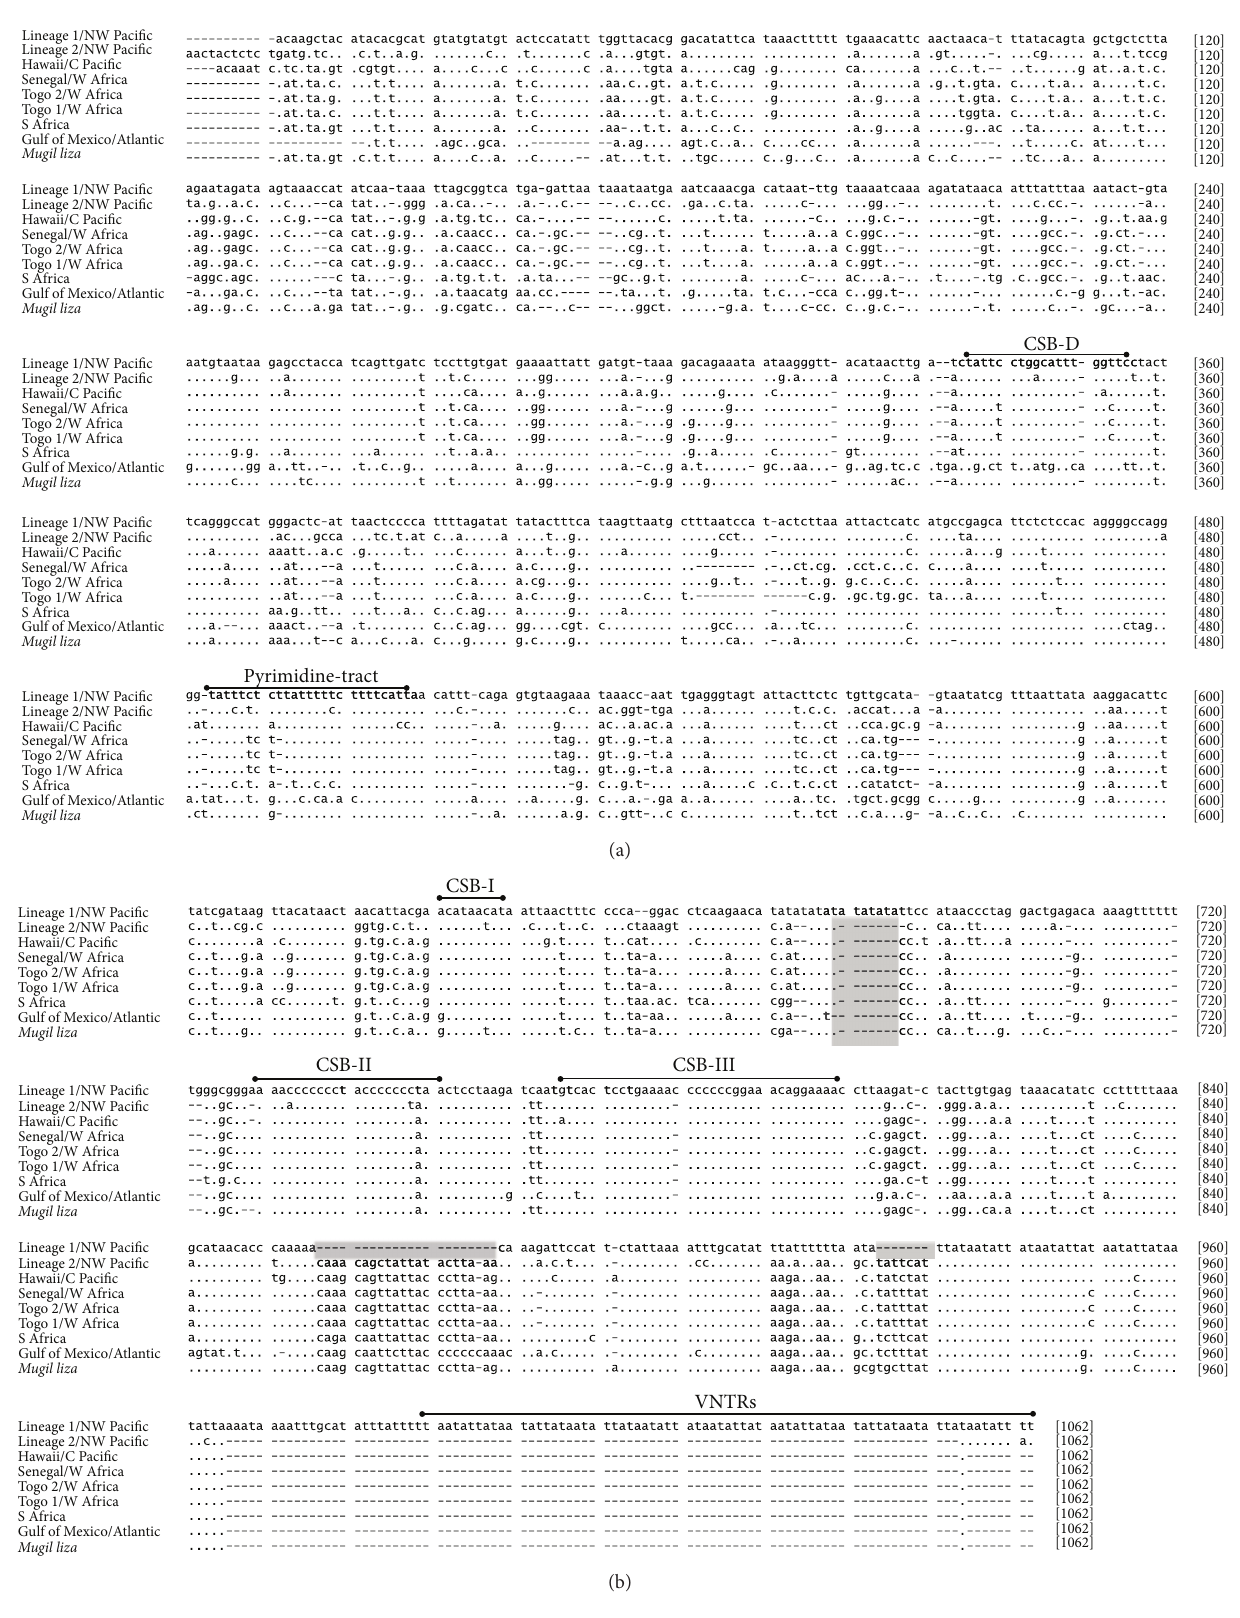
Lineage 1/NW Pacific Lineage 2/NW Pacific Hawaii/C Pacific Senegal/W Africa Togo 2/W Africa Togo 1/W Africa S Africa Gulf of Mexico/Atlantic Mugil liza